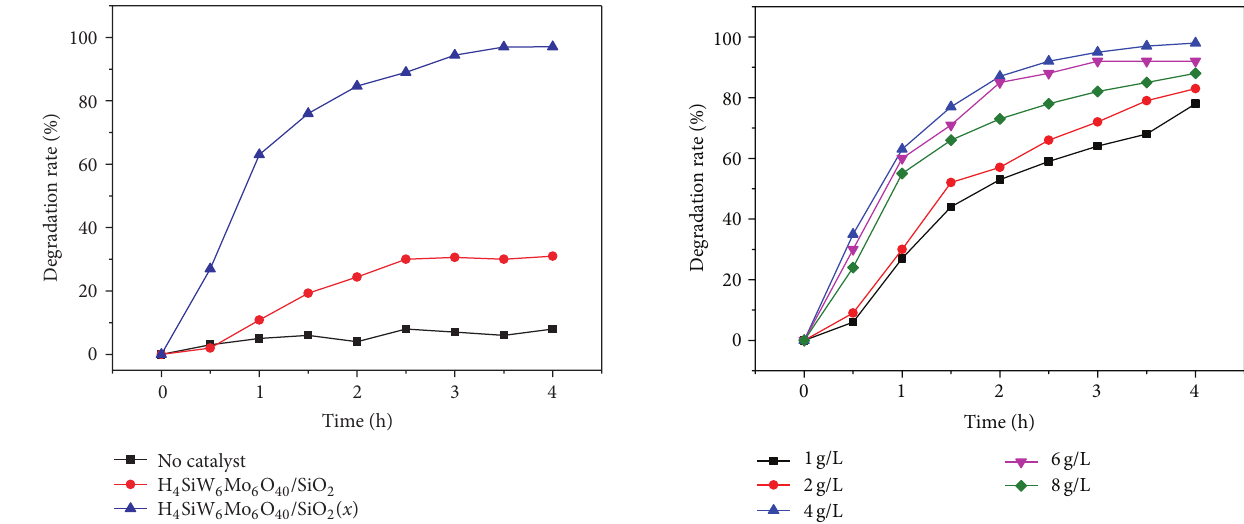
Figure 7: Effect of catalyst dosage on photocatalytic activity of catalyst.